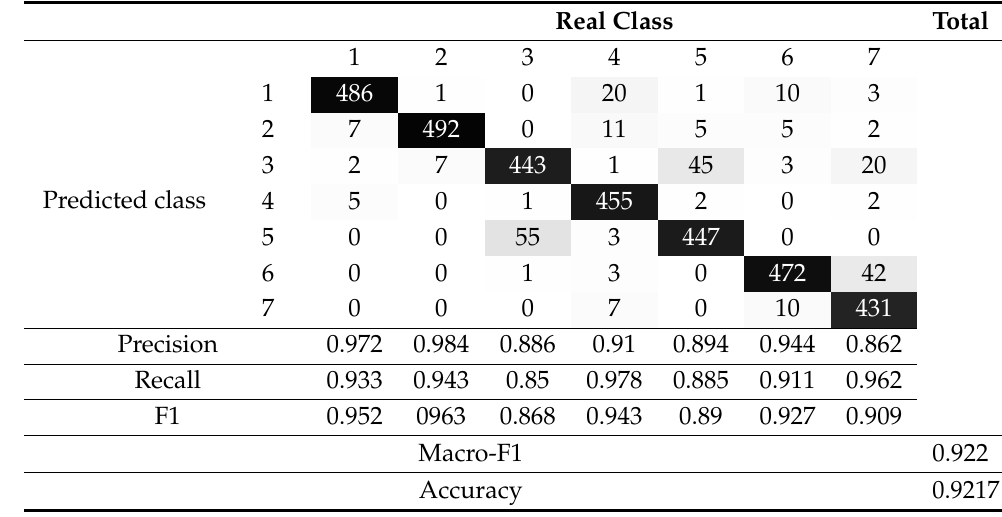
Table 5. Confusion matrix and metrics of EfficientNetB0 initialized using